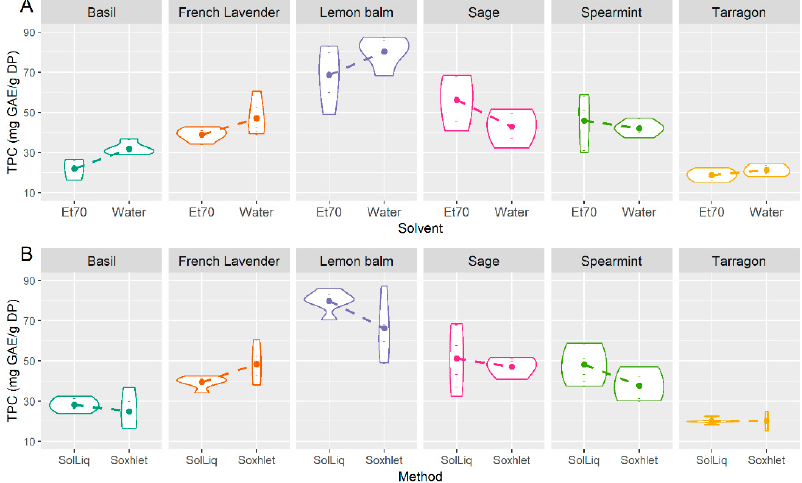
Figure 3. Interaction plots “plant × solvent” ( A ) and “plant × method” ( B ) on the total phenolic content of plant extracts.